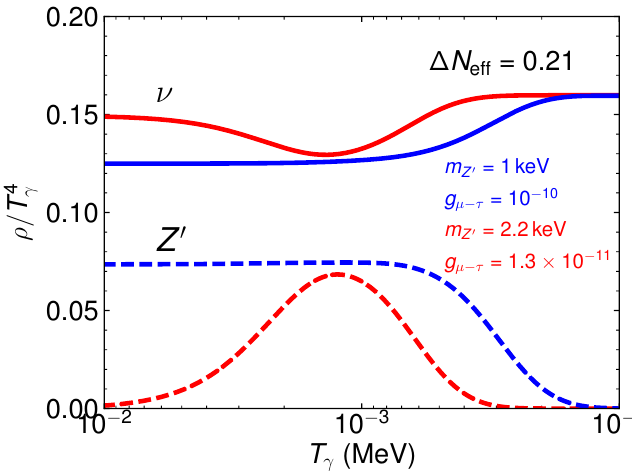
Figure 7 . The evolution of the neutrino (solid) and Z 0 (dashed) energy densities in a regime in which only decays and inverse decays are e(cid:11)ective and occur after neutrino decoupling. The red lines correspond to a situation in which the Z 0 thermalizes at a temperature similar to its mass T (cid:23) (cid:24) m Z 0 , prior to which its energy density was negligible. In blue we show a case in which the Z 0 population equilibrates with the neutrinos while still